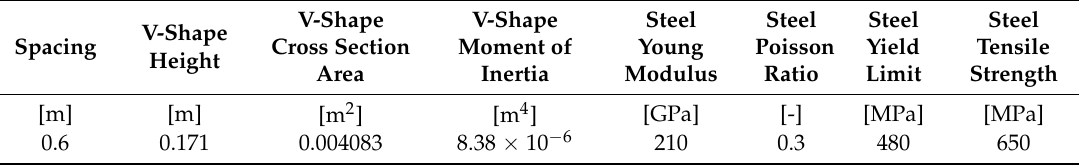
Table 1. Parameters of steel yielding